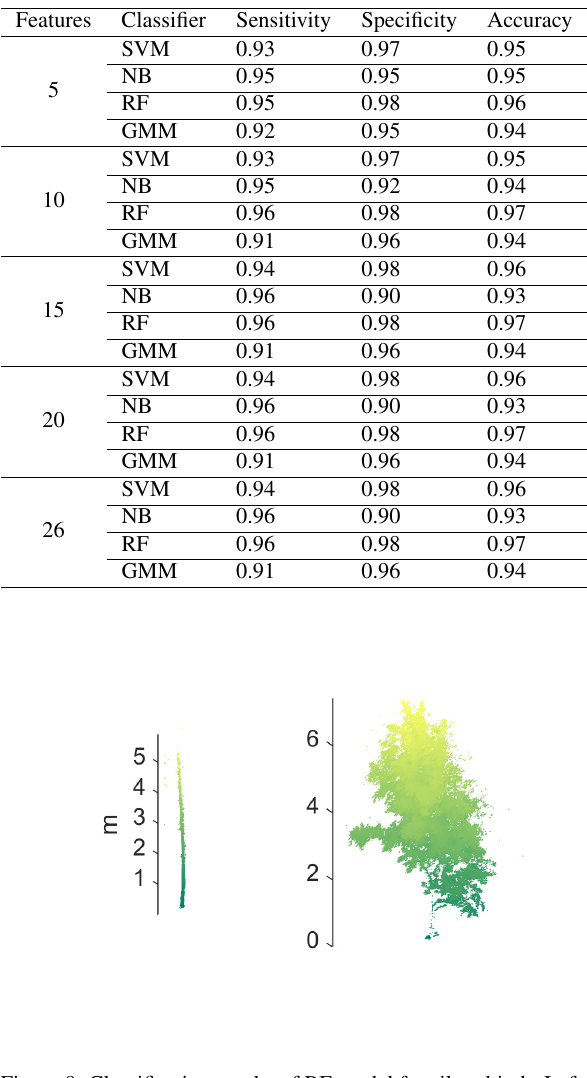
Figure 8. Classification results of RF model for silver birch. Left part shows the wood components and right part shows the leaf points.